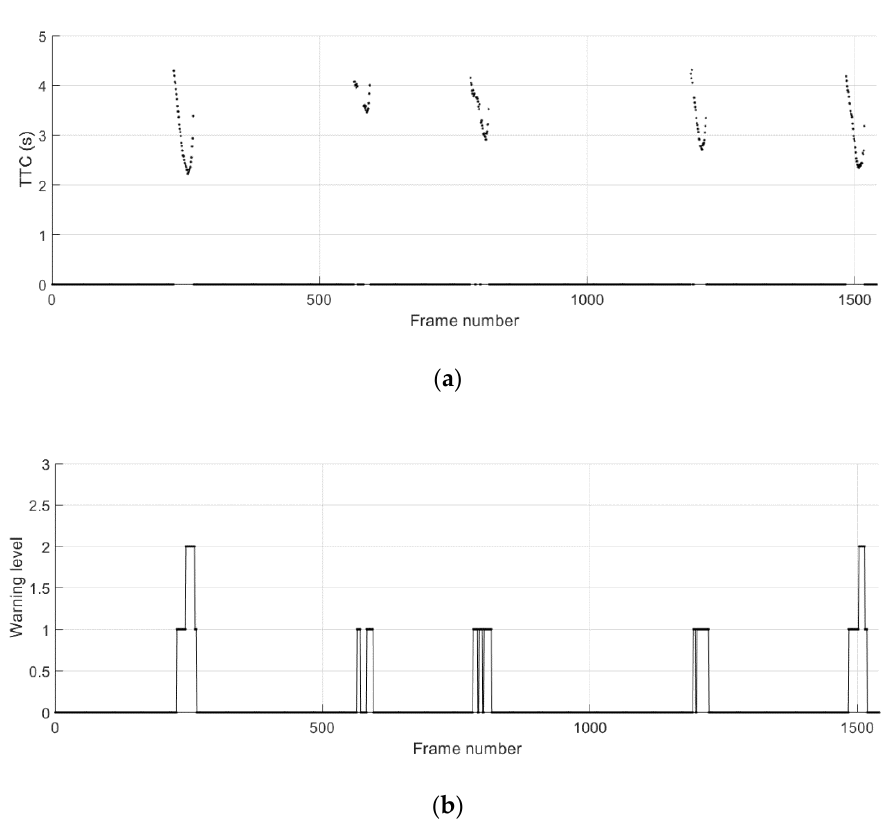
Figure 16. Potential crash events predicted during the cut-in driving scenario 2. ( a ) Time-to-collision (TTC); ( b ) collision warning level.